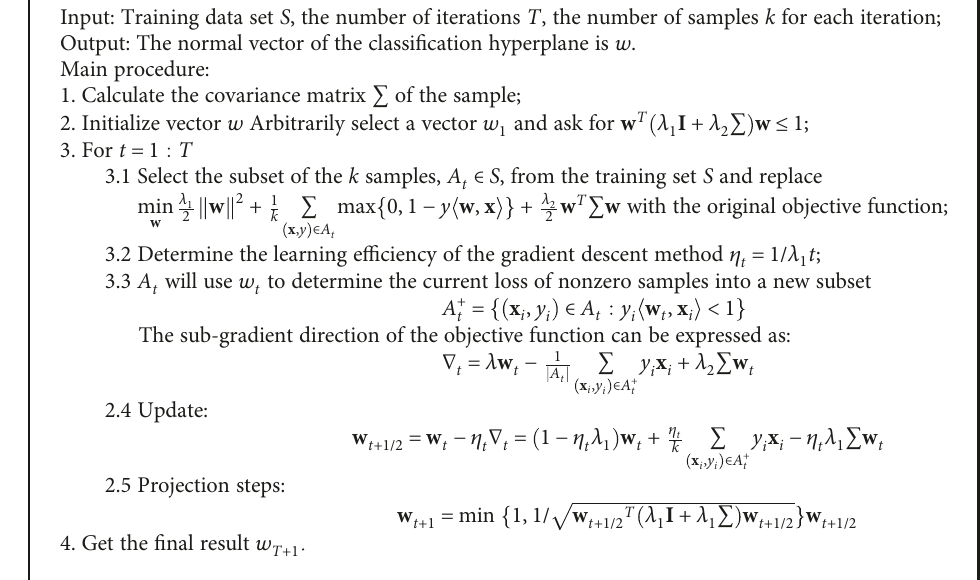
Algorithm 2: Pegasos algorithm for structured